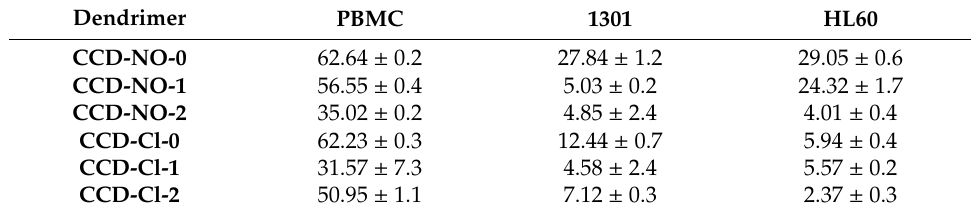
Table 4. IC 50 values of copper metallodendrimers in normal peripheral blood mononuclear cell (PBMC) and cancer: 1301, HL-60 cell lines after 24 h incubation. The values are the mean ± SD of n ˃